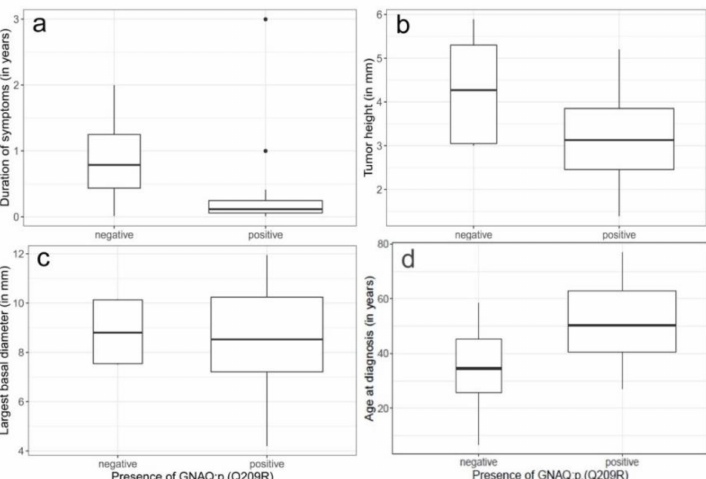
Figure 2. ( a – d ) Distribution of clinical characteristics between the mutation negative and mutation positive cohort. ( a ) duration of symptoms, ( b ) tumor height, ( c ) largest basal diameter, and ( d ) age at diagnosis. Boxplots with median represented as a solid line. Rectangles show the interquartile range. Width of the rectangles corresponds to the number of patients. None of the tested correlations is statistically significant.